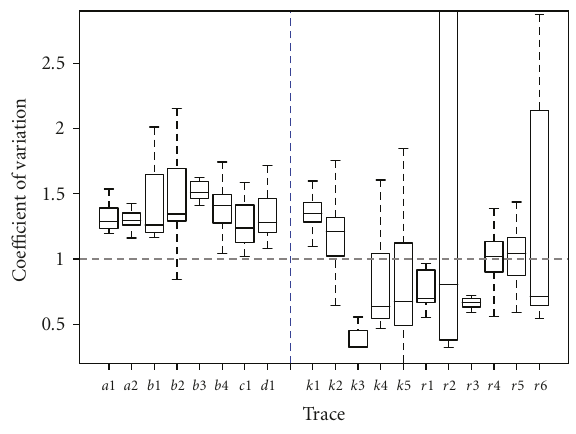
Figure 9: Coe ffi cient of variation computed from packet interar- rival times for each trace. Each group of 500 interpacket times is computed